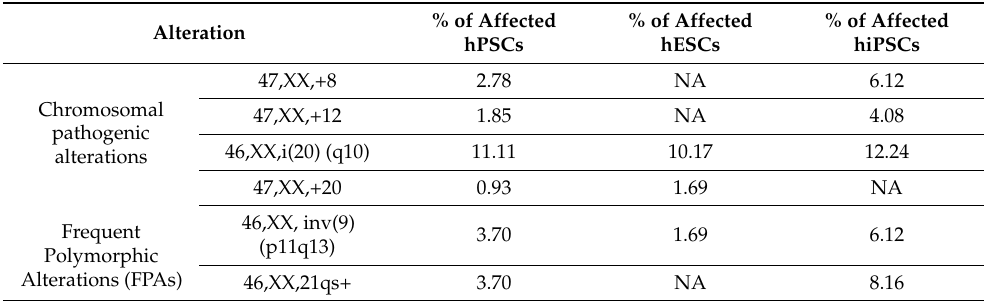
Table 2. List of chromosomal alterations detected by G-banding in human embryonic stem cell (hESC) and human induced pluripotent stem cell (hiPSC)